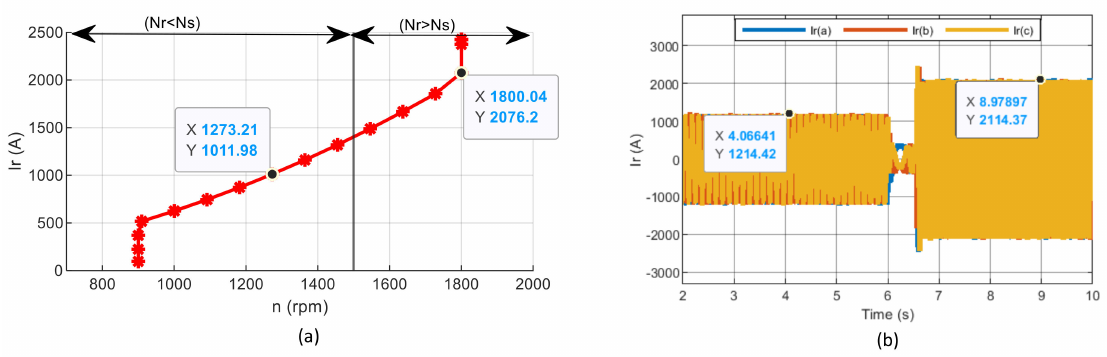
Figure 8. ( a ) Calculated rotor current; ( b ) Rotor current of the designed system. The values of stator voltage are calculated to be 563.383 V, which is similar to the simulated SS value of 563.382 V for all operating points as the stator voltage remains constant. Figure 9a,b show the values for comparison.